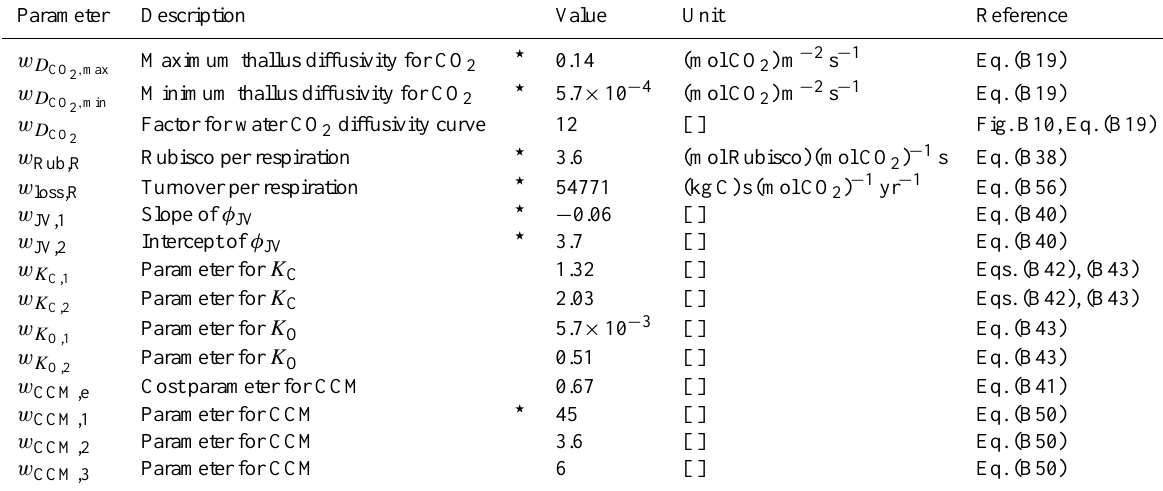
Table B10. Overview of model parameters associated with lichen or bryophyte tradeoffs. Parameters marked by the ? -symbol are included in a sensitivity analysis (see Table 2) because their values are not known very accurately. Note that in some cases several parameters are changed simultaneously to test model sensitivity towards a certain property, e.g. both w D of the CCM parameters is included in the sensitivity analysis: changing w CCM,e would be redundant since decreasing the costs of the CCM is analogous to increasing its positive effect. w CCM,2 and w CCM,3 are only relevant at a transient state of very high pore space CO 2 levels.